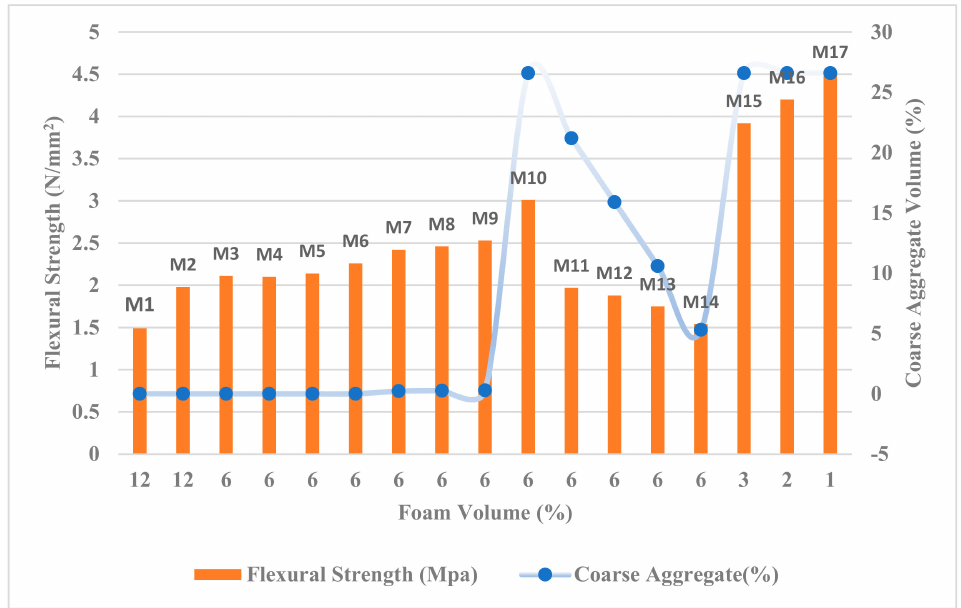
Figure 13. Flexural Strength vs. Coarse Aggregate vs. Foam Volume of FC.